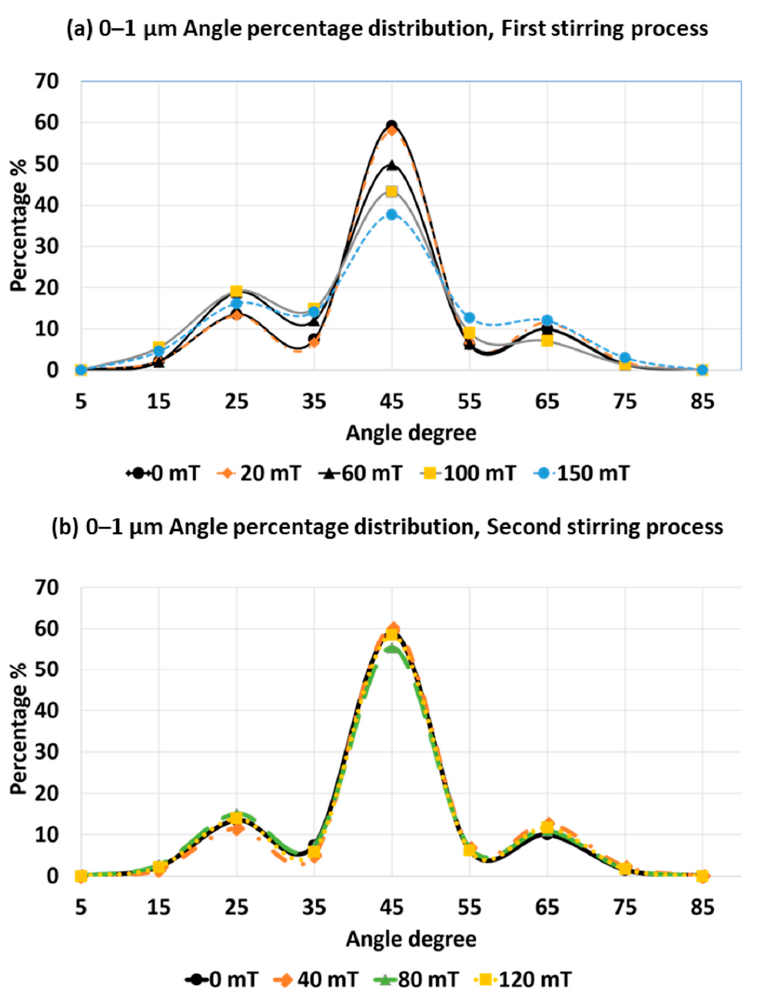
Figure 7. Angle distribution curves of fine eutectic Si lamella (<1 μ m) of Al–Si eutectic specimens. ( a ) First stirring process (Steps 1 and 2). ( b ) Second stirring process (Steps 3 and 4). After the first stirring process, the samples were solidified without an instant effect